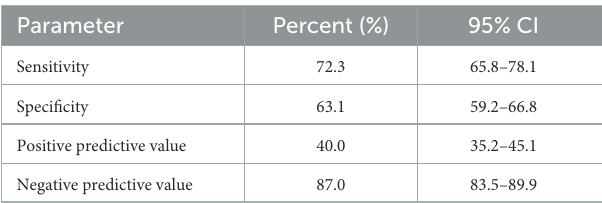
TABLE 2 Sensitivity, specificity, positive predictive value, negative predictive value and accuracy of HOMA-IR ≥ 2.1 corresponding to